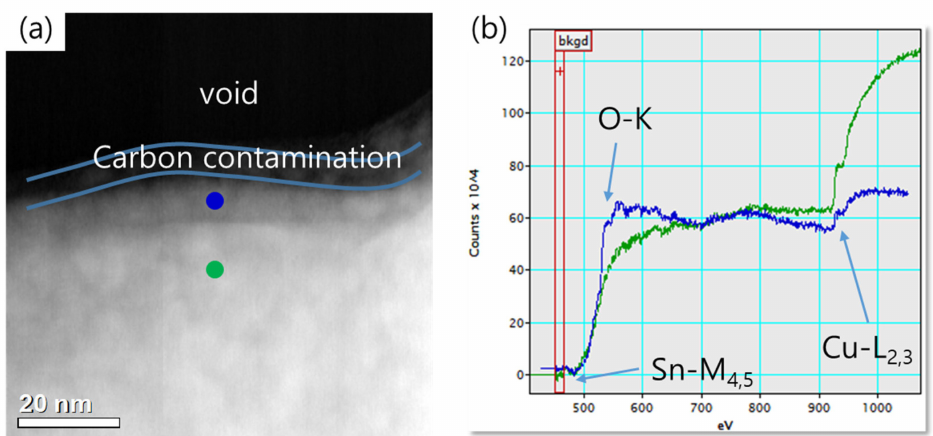
Figure 7. ( a ) TEM micrograph and ( b ) EELS spectrum of void area (square) in Figure 6e; blue for the interface and green for the underlayer. Carbon contamination originated from sample the preparation.